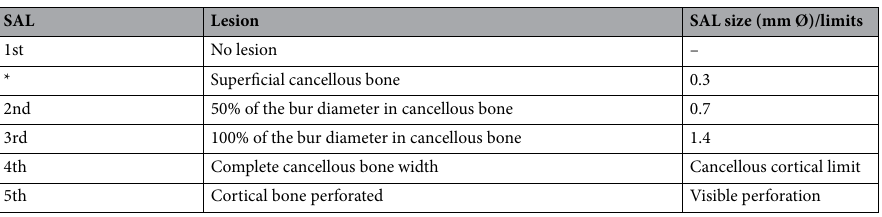
Table 1. Simulated apical lesions (SAL) stages at which the specimens were X-rayed (CBCT and DIR) and photographed (bur diameter ± 0.02 mm; * = this SAL-stage was prepared only for the purpose of defining the SAL location, thus, not evaluated).